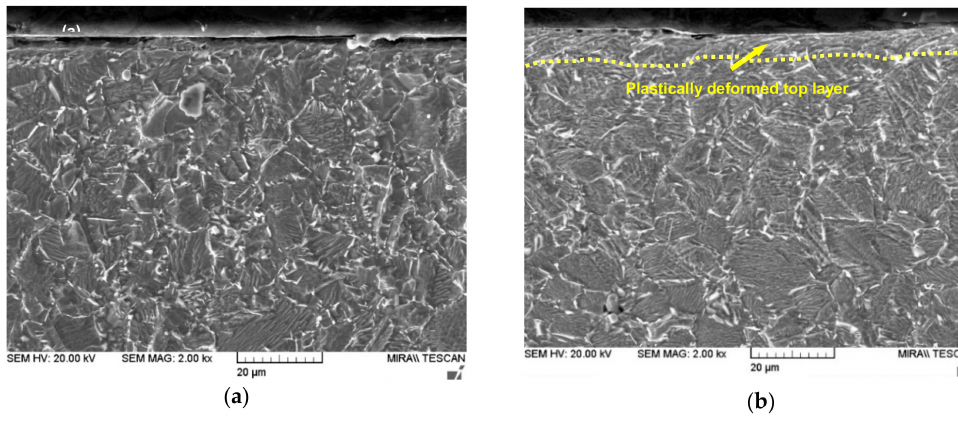
Figure 5. Cross-sectional SEM images of the as-received ( a ) and UNSM-treated ( b )